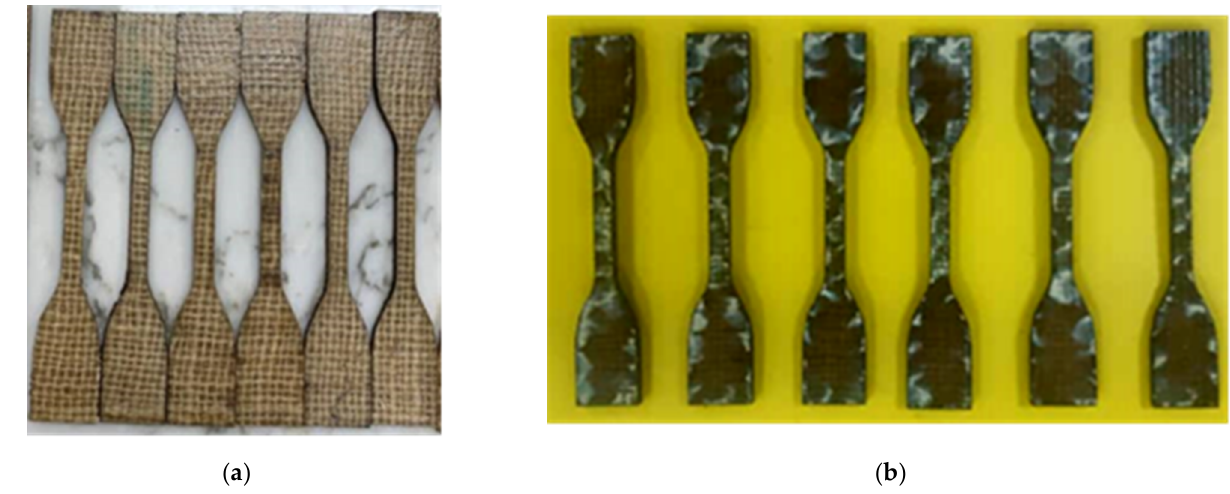
Figure 10. Tensile specimen ( a ) before and ( b ) after being immersed in distilled water for 28